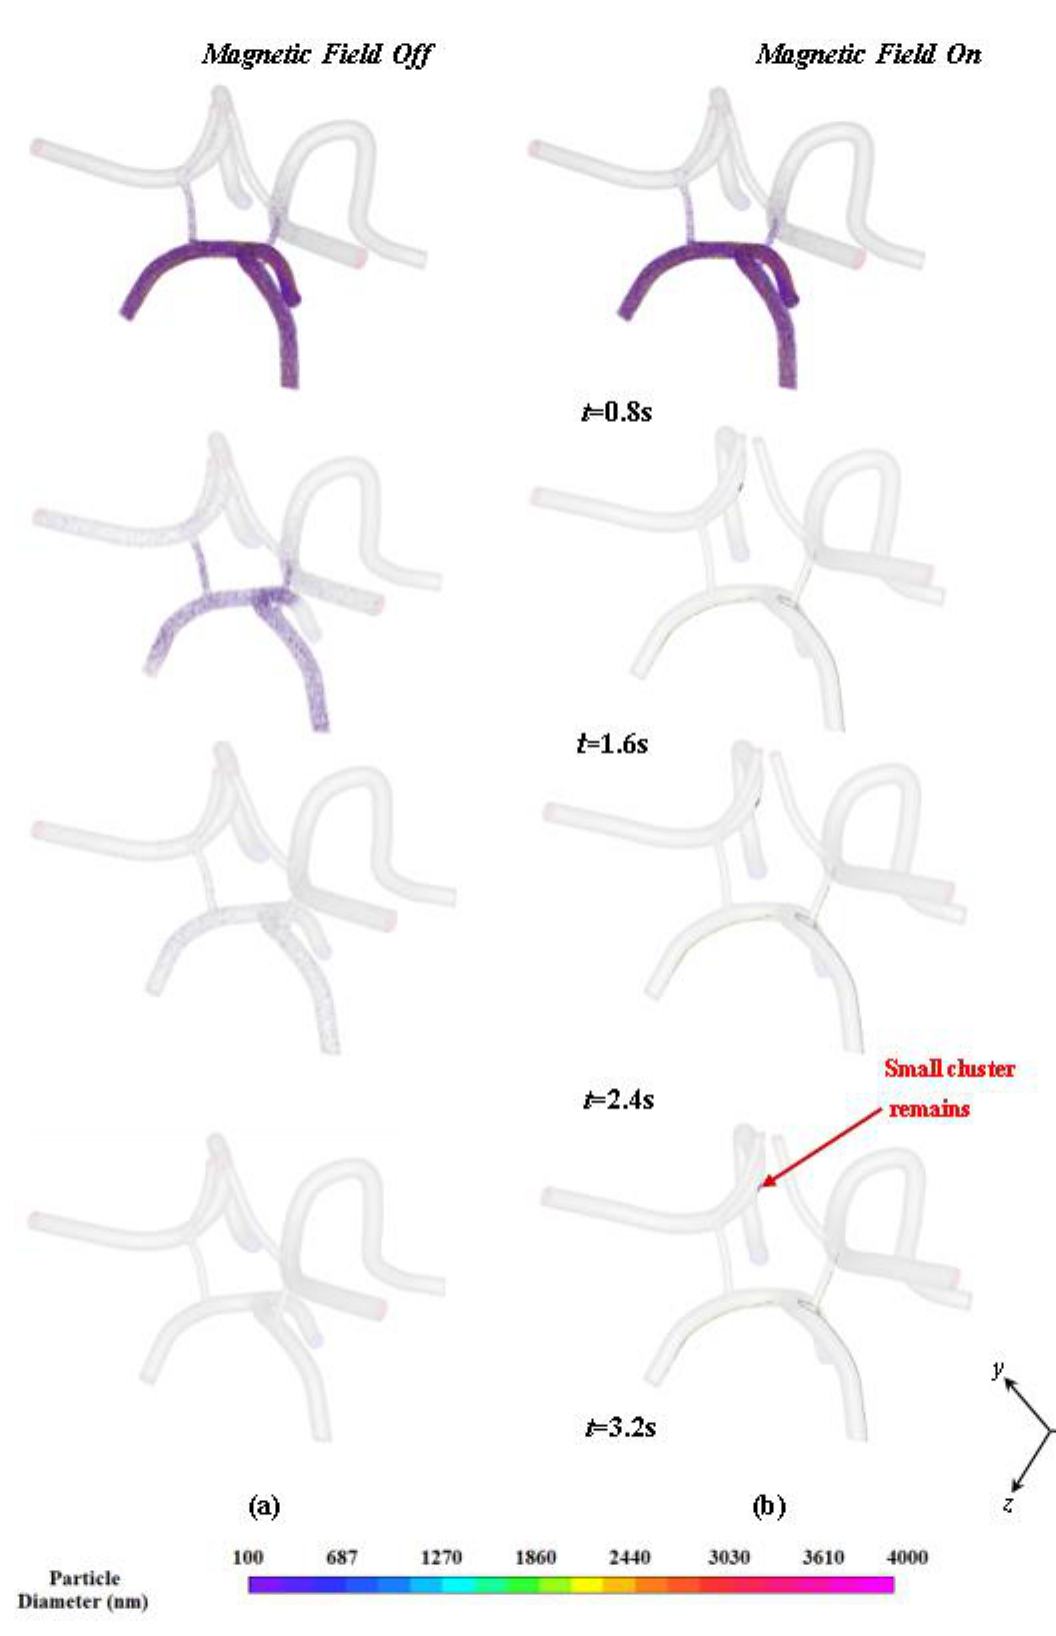
Figure 9. Heterogenous particle distribution in the CoW model at different time instances: ( a ) without a magnetic field and ( b ) with a magnetic field turned on at 0.8 s and for the duration of the tracking.